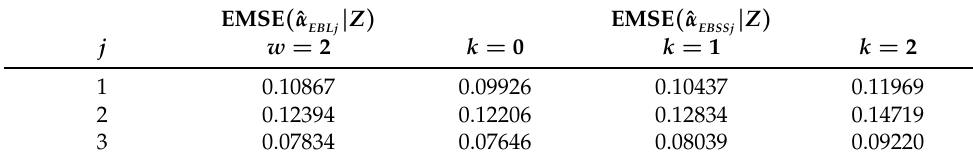
Table 12. Results of calculated EMSE for ˆ α using s = 10, β = 0.6434, u = 3, v =